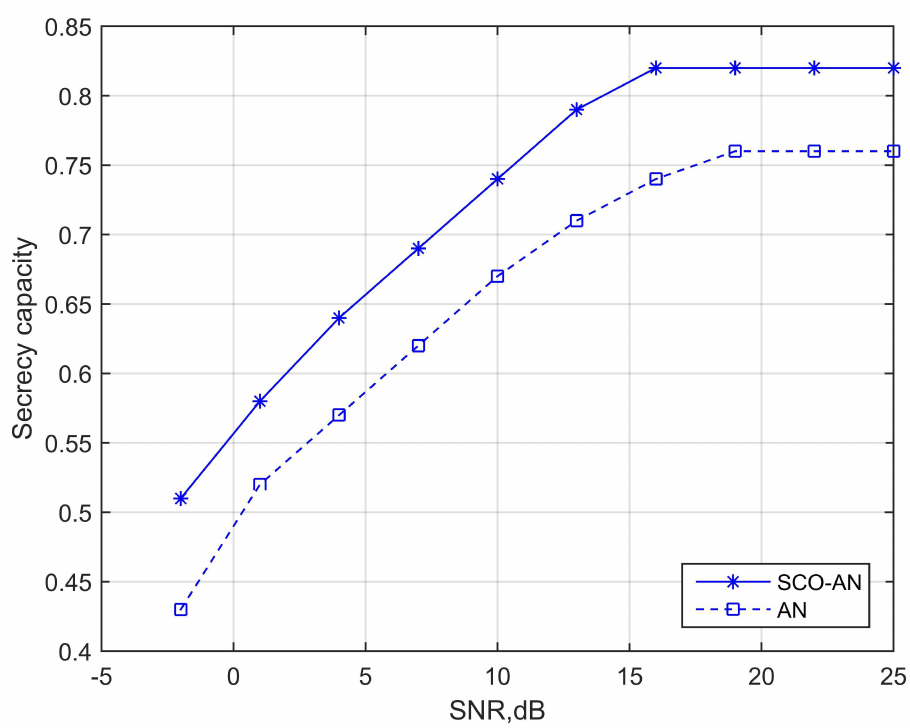
Figure 2. Secrecy capacity comparison of the AN and SCO − AN versus different